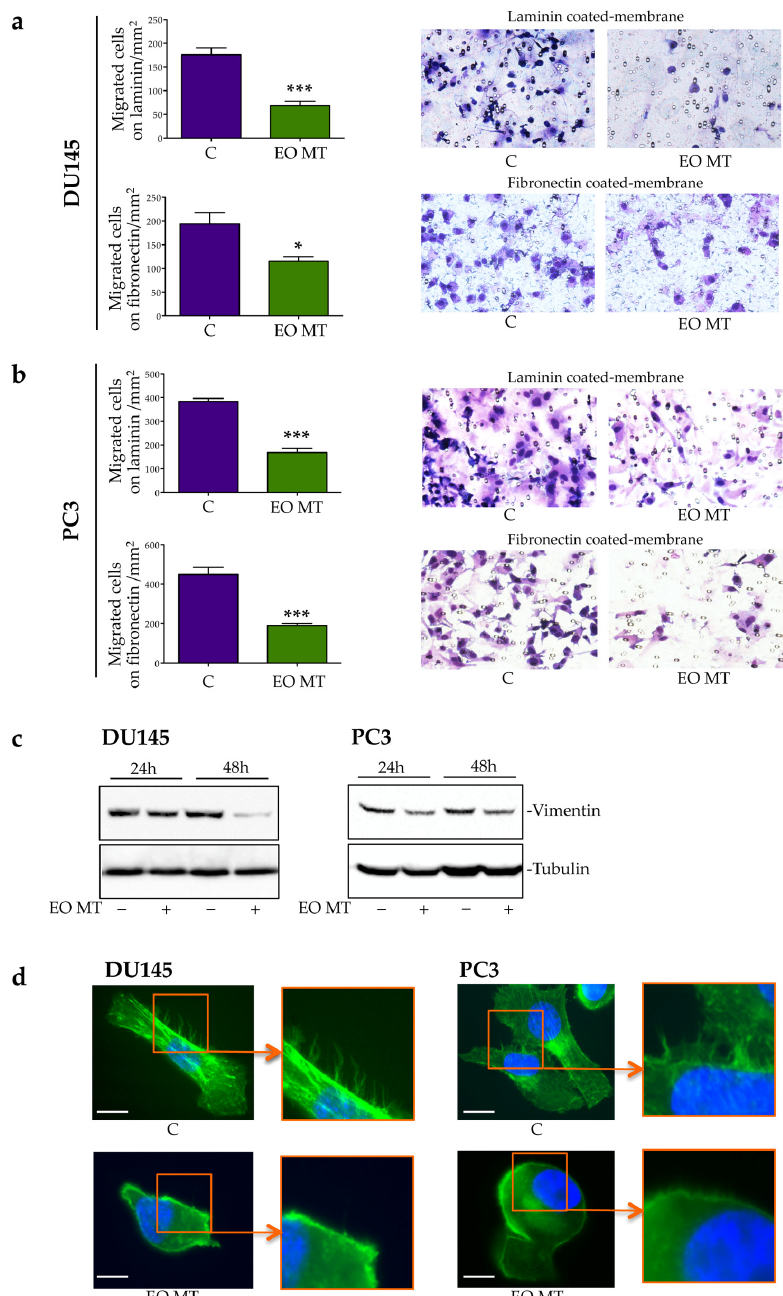
Figure 4. Effect of Myrtus communis subsp. tarentina (L.) Nyman (EO MT) on cell migration, vimentin expression, and actin rearrangement of DU145 and PC3 cells. Cellular motility of DU145 ( a ) and PC3 ( b ) cells was analyzed by Boyden’s chamber assay. The migratory capacity of control (C) and EO MT (400 µ g/mL)-treated cells was analyzed both on laminin-coated and fibronectin-coated membranes. Representative images of migrated cells in each condition are shown (( a , b ) on the right). The graph on the left reports the quantification of migrated cells/mm 2 . Data were analyzed by a one-way ANOVA with Student’s post test (* p < 0.05 vs. C and *** p < 0.0001 vs. C). Western blot analysis of vimentin ( c ) in CRPC cells treated with EO MT (400 µ g/mL) for 24 h and 48 h was performed. Tubulin was used as a loading